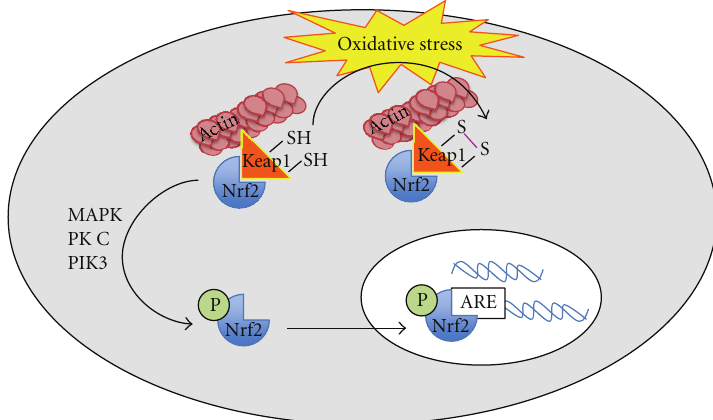
Figure 2: Oxidative stress induces Nrf2 dissociation from Keap1. Nrf2 is activated by phosphorylation and translocated into the nucleus where it may act as a transcription factor for antioxidant response